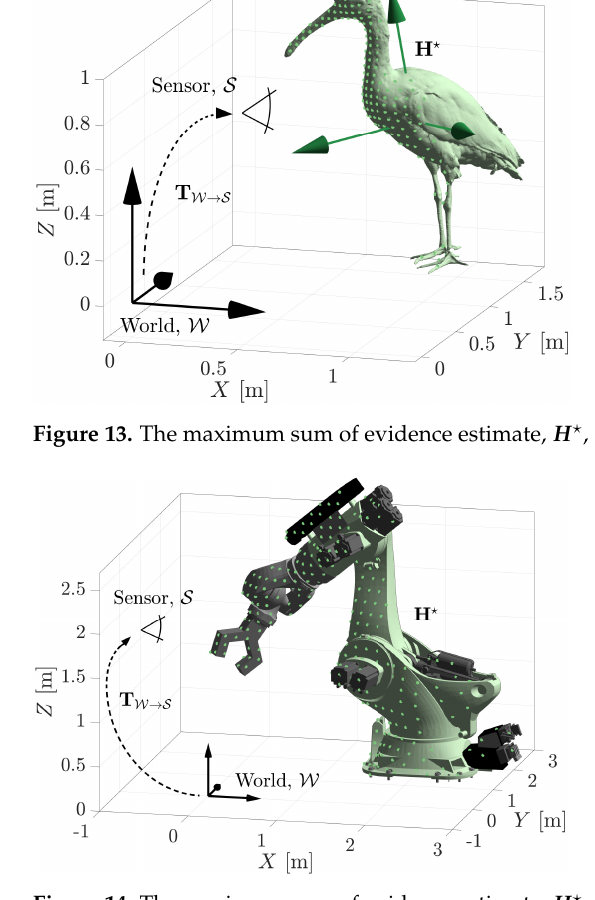
ured at H truth = [ θ 1:6 ] = [ 10 ◦ , − 80 ◦ , 120 ◦ , − 50 ◦ , 30 ◦ , − 10 ◦ ] . After 10 iterations of